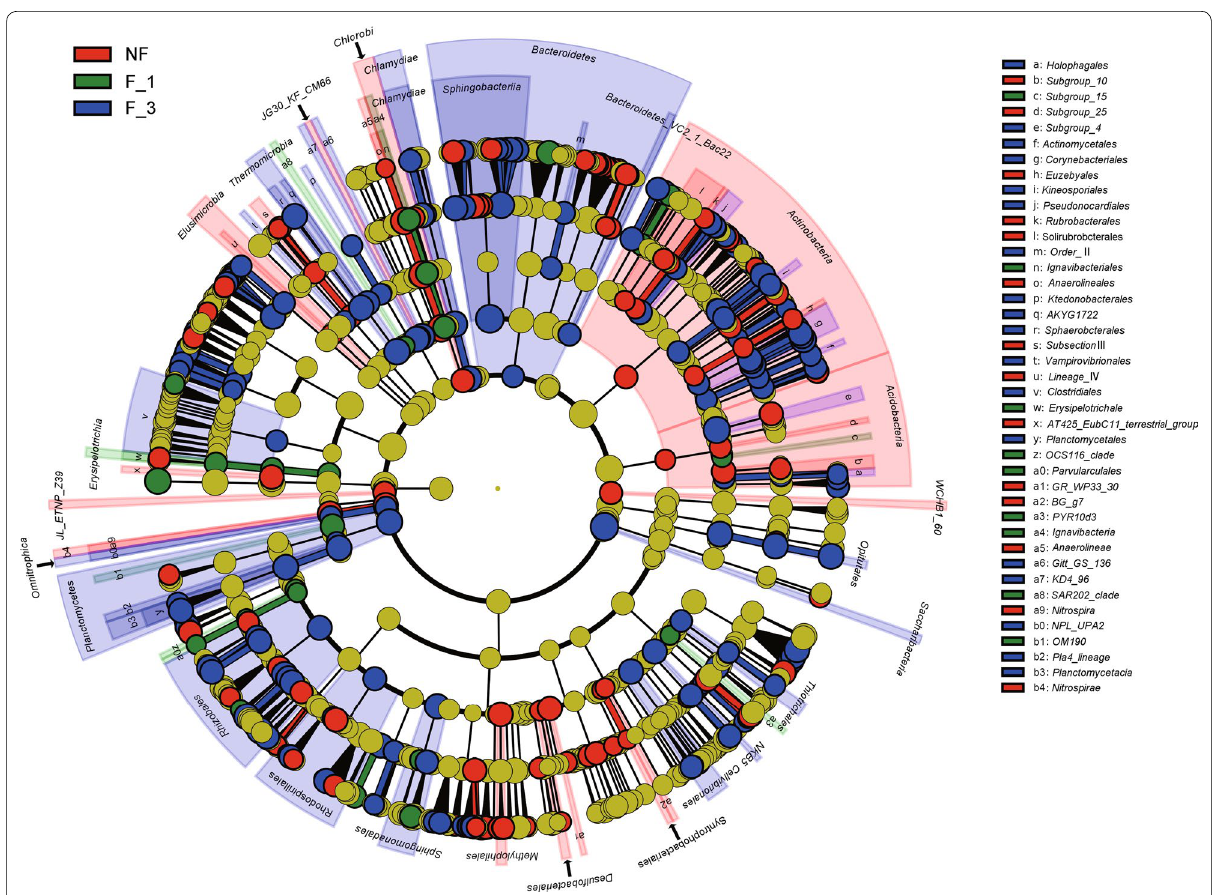
Fig. 6 Lefse cladogram of the aggregated group of NF, F_1, and F_3. A range of bacterial taxa from phylum to genus level was associated with the NF (red), F_1 (green) and with F_3 (blue) (α 0.05, LDA > 2.0, the size of circles is proportionate to each taxon’s mean relative abundance). The = yellow circles represents no significantly different taxa. NF non-fumigation, F_1 chloropicrin-fumigation for 1 year, F_3 continuous chloropicrin- fumigation for 3